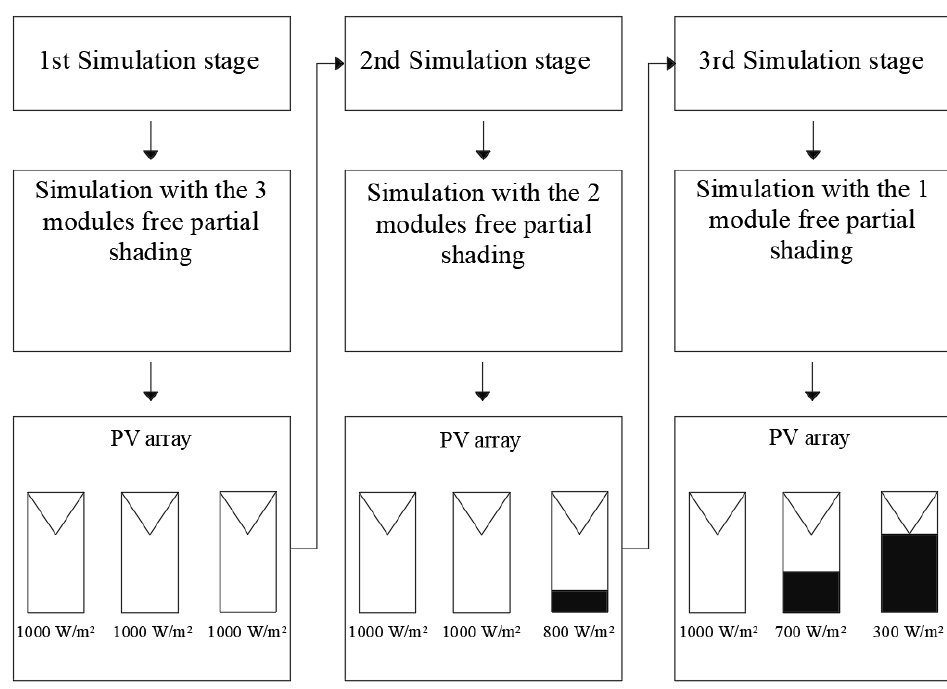
Figure 7. Flowchart of the implemented simulation steps.